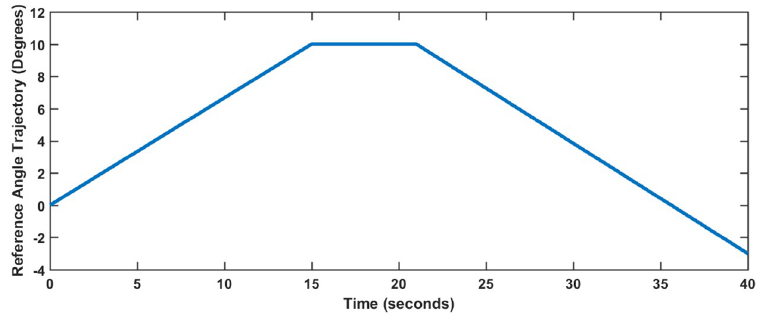
Fig 12. Reference trajectory for the robotic